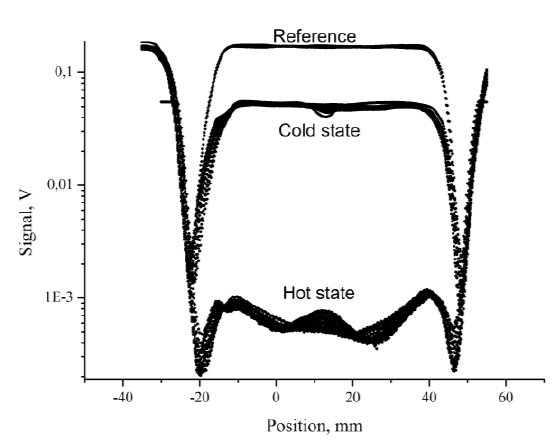
Fig. 3. The THz transmittance of 3-inch VO 2 films on r- Al 2 O 3 at different position from the center (10 mm).